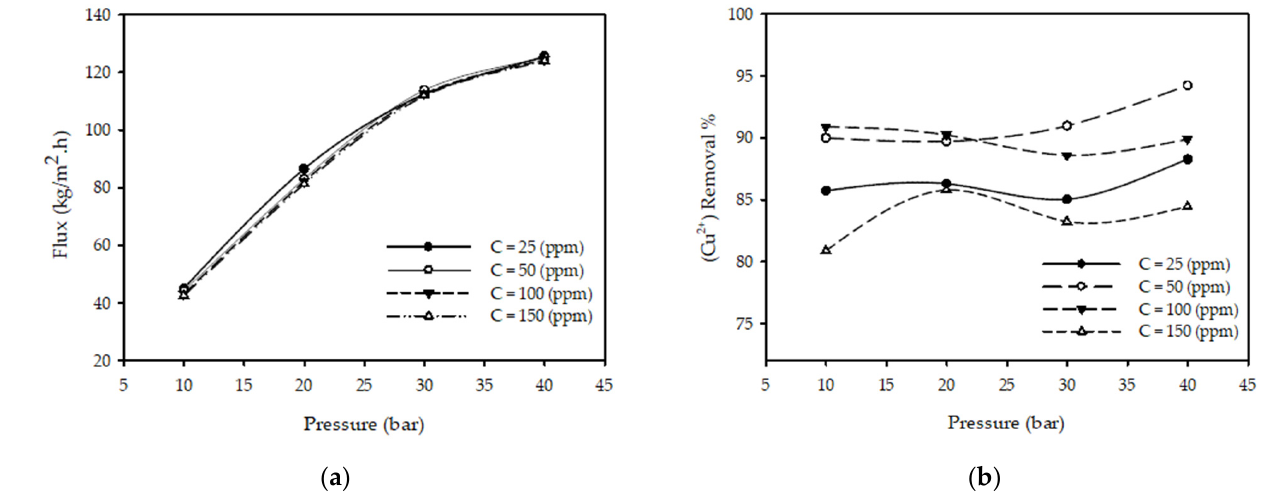
Figure 2. Effect of pressure on ( a ) permeate flux ( b ) (Cu 2+ ) removal % at different feed concentrations for constant feed flow rate 2 (L/min) and feed temperature 25 (°C).